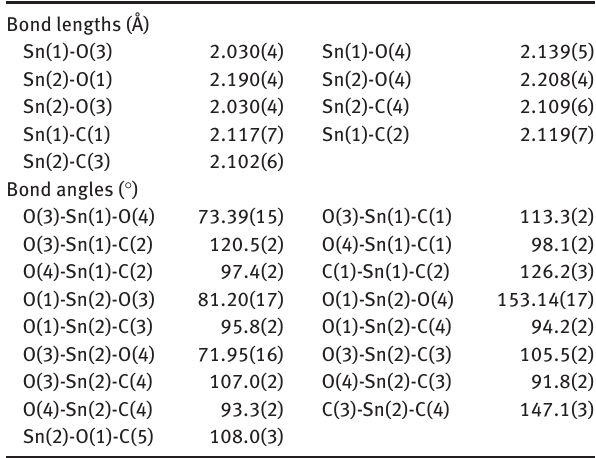
Table 2: Selected bond lengths (Å) and bond angles ( ° ) for complex